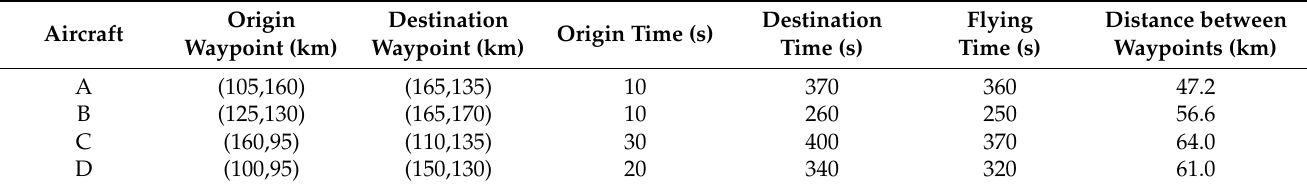
Table 1. Flight plan for four aircraft.